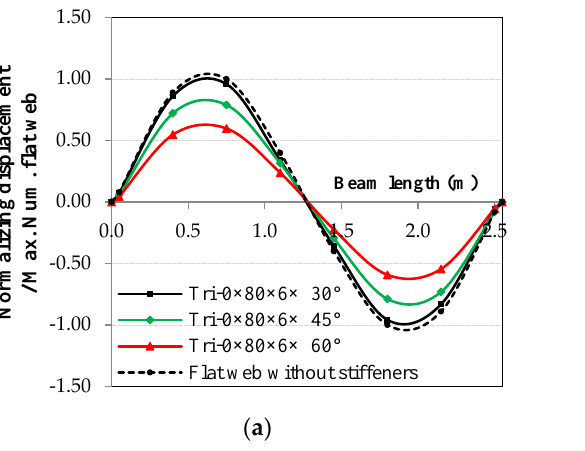
Figure 19. Corrugated angle effect on the relationship between normalized displacement and beam length for the 2nd mode shape: ( a ) triangular web and ( b ) angle effect at the 2nd mode shape.